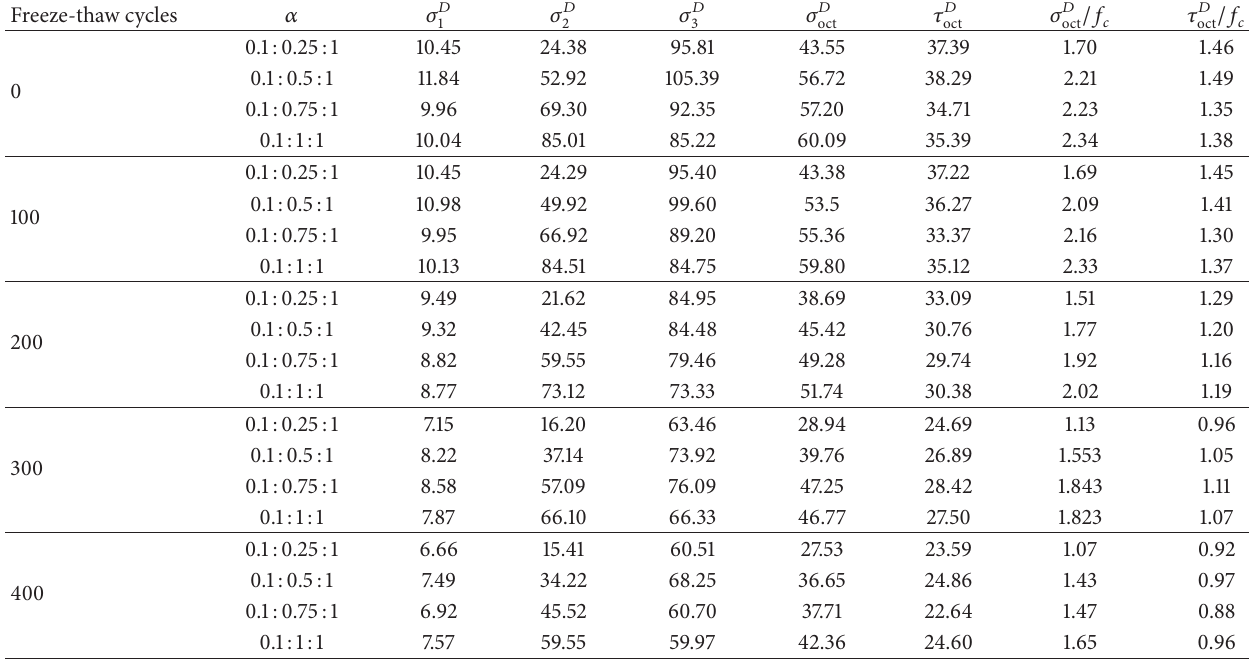
Table 2: Experimental results of air-entrained concrete under triaxial compression after rapid freeze-thaw cycles (MPa). Freeze-thaw cycles